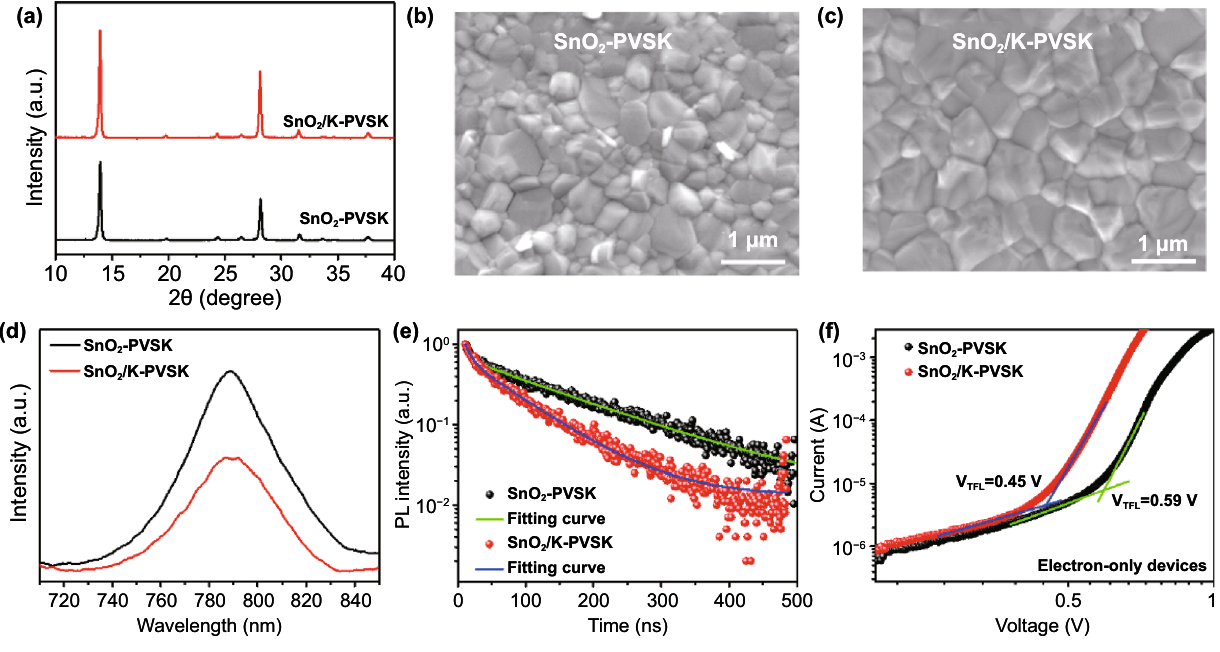
Fig. 3 Characterization of Perovskite Films Based on SnO 2 and SnO 2 /K Substrates. a X -ray diffraction patterns of the perovskite films deposited on SnO 2 and SnO 2 / K substrates. Top view of SEM images of the perovskite films deposited on b SnO 2 substrates and c SnO 2 /K substrates. d PL spectra and e TRPL curves of the perovskite films deposited on SnO 2 and SnO 2 /K substrates. f Dark I–V curves of the perovskite films based on electron-only